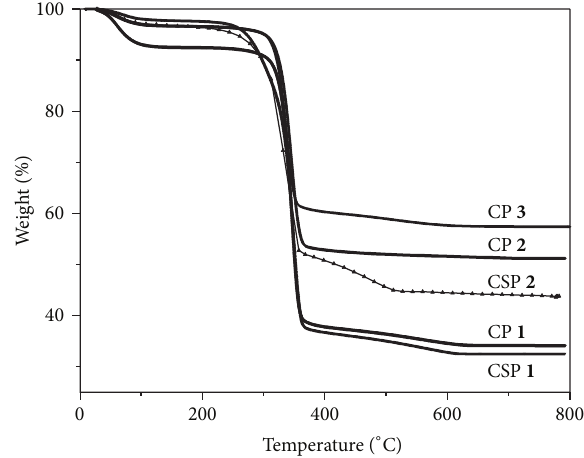
Figure 2: TGA curves of the composite particles and the CSPs.